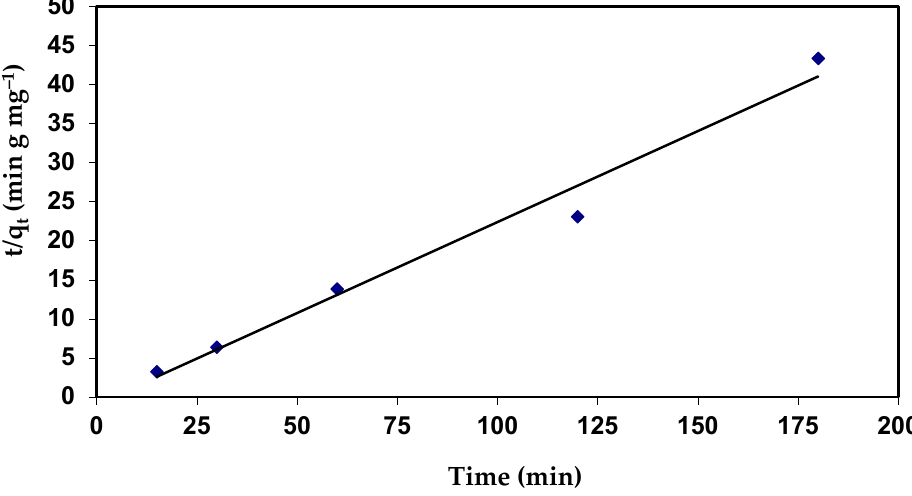
Figure 16. Pseudo-second-order plots for the adsorption of CVD onto S. costatum .